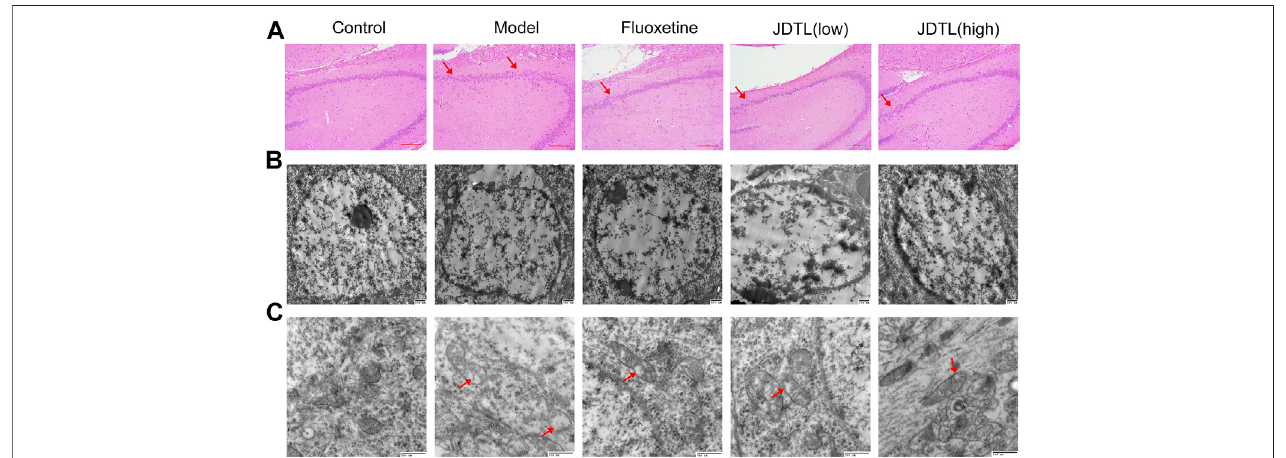
FIGURE 4 | Histological and Ultrastructural Changes Associated with JDTL Granules Treatment. H&E staining of the hippocampal CA3 area [ (A) , × 40]. Cells were structurally intact and with clear cytoplasm in the control group. In the model group, degeneration and necrosis occurred with reduced cells, scattered arrangement (arrow), and condensed and deep stained nucleus. Minor damage was observed in JDTL granules and fl uoxetine groups. Ultrastructural characteristics of the nucleus [ (B) , × 20,000] and mitochondria [ (C) , × 40,000] in the hippocampal area. The control group neurons were with intact shape and uniform chromatin in the nucleus. Furthermore, the mitochondria were apparent and remained intact. The model group ’ s nucleus showed nuclear pyknosis, and the mitochondria deform, swell, and vacuolization (arrow). The treatment of JDTL granules and fl uoxetine reduced the damage.